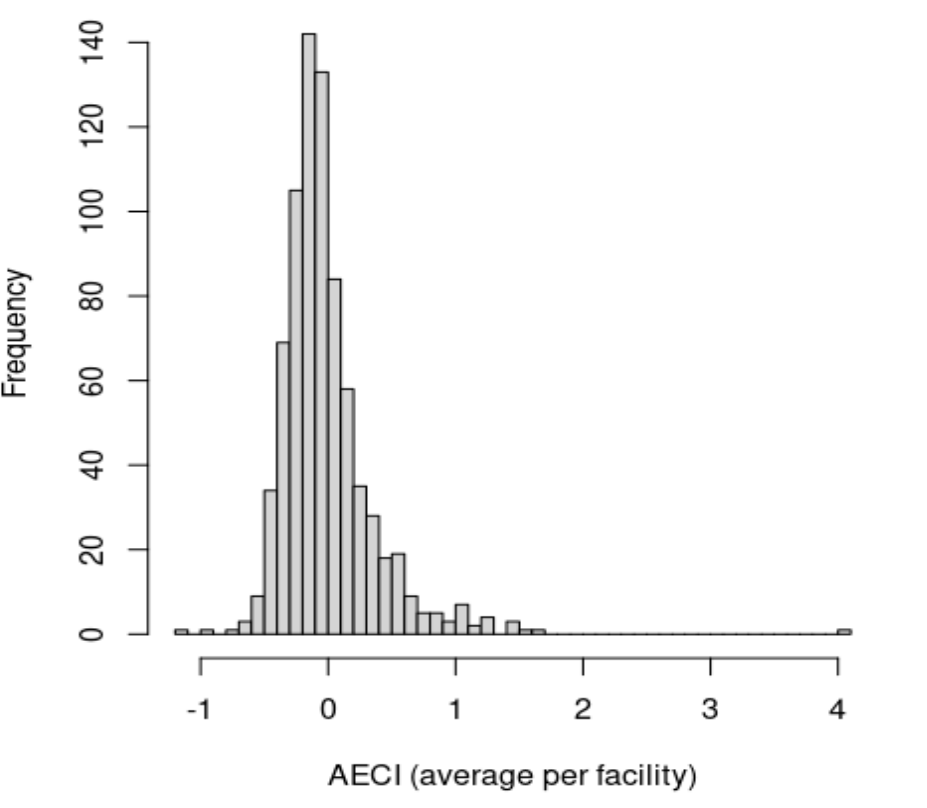
Figure 3. Histogram of the unexplained variability in excess coding intensity (represented by the AECI metric) averaged by facility.